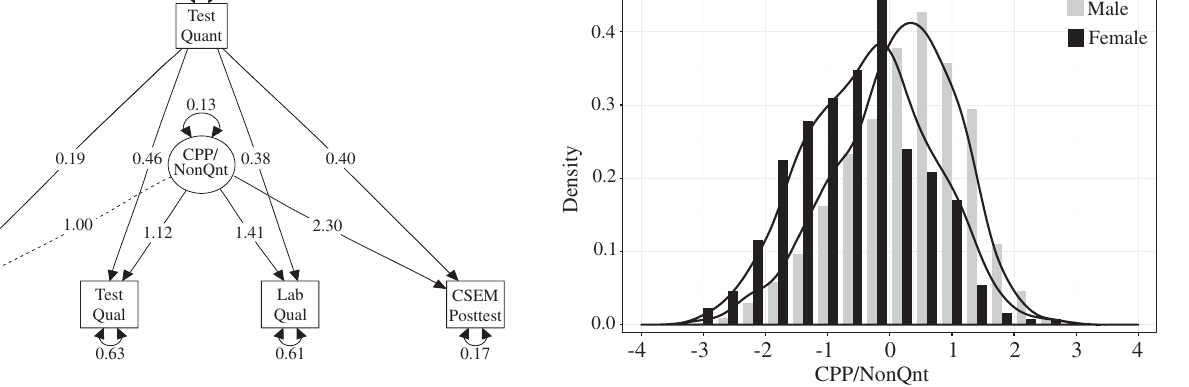
FIG. 5. The distribution of male and female students ’ CPP/ NonQnt. Density plots are drawn for men and women; the male plot reaches its maximum to the right of the maximum of the female plot. The male and female histograms are displaced by the width of 1 bar so that the histograms do not overlap. The density curves were not